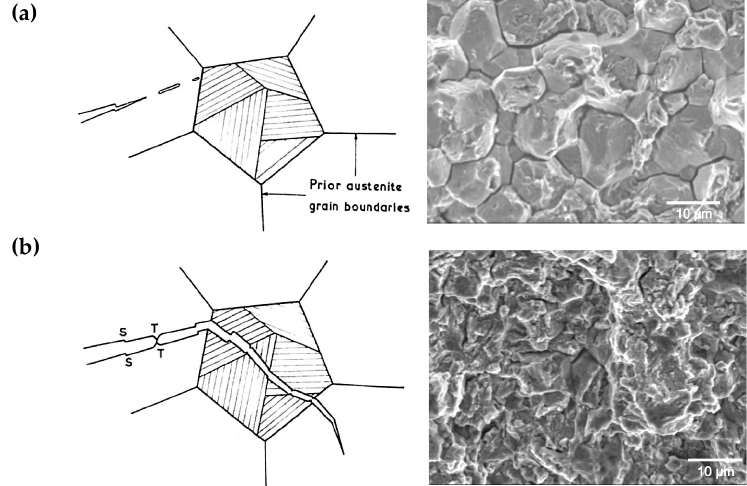
Figure 1. Appearance of brittle fracture after mild hydrogen charging of martensitic steel. ( a ) Intergranular fracture path is along prior austenite grain boundaries and martensite packet boundaries caused by hydrogen-enhanced grain boundary decohesion (HEDE); ( b ) Transgranular fracture path along lath boundaries accompanied by trans-lath steps (S), localized plastic tearing (T) by dislocation pile-up and hydrogen-enhanced local plasticity (HELP).